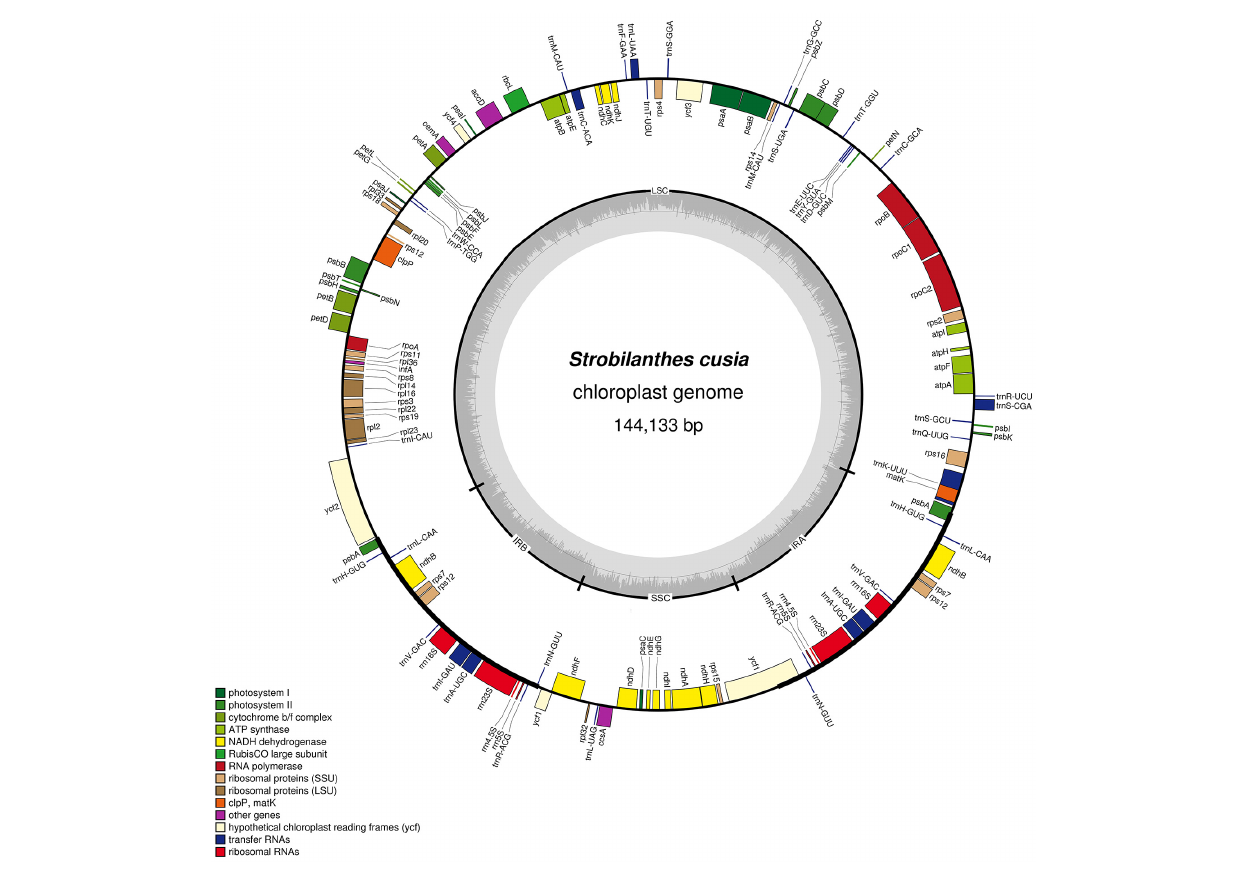
FIGURE 1 | Gene map of S. cusia cp genome. Genes inside and outside of the circle are transcribed in the clockwise and counterclockwise directions, respectively. LSC, large single-copy region; SSC small single-copy region; IR, inverted